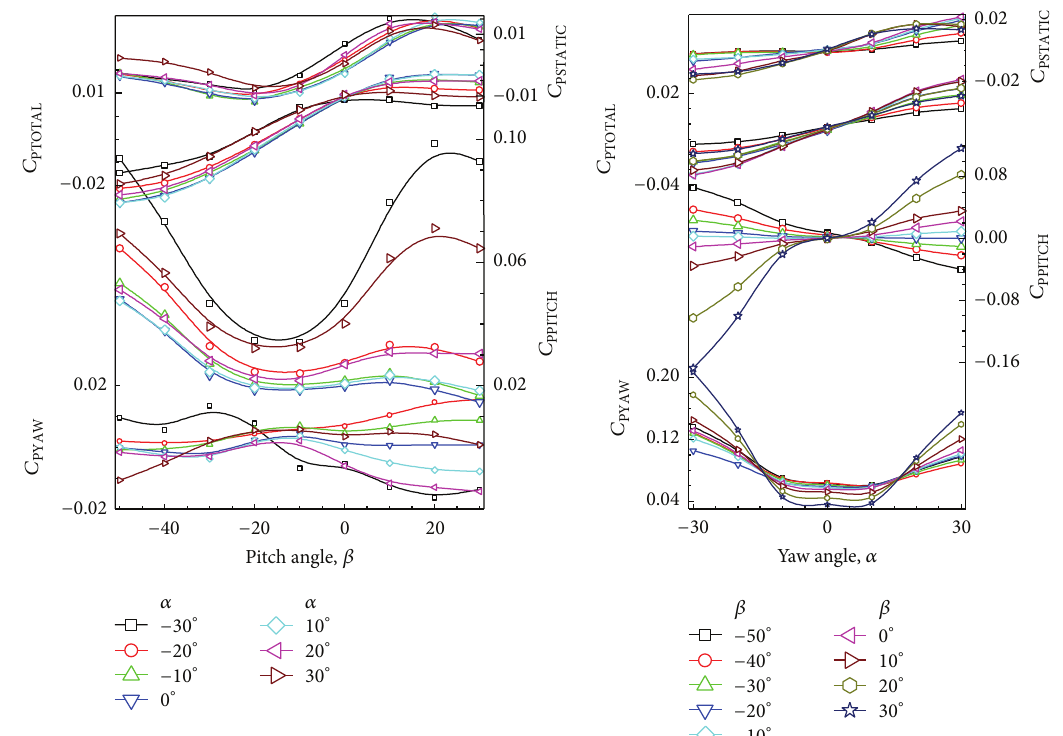
Figure 8: Sensitivity curves of the calibration coefficients in the center zone.